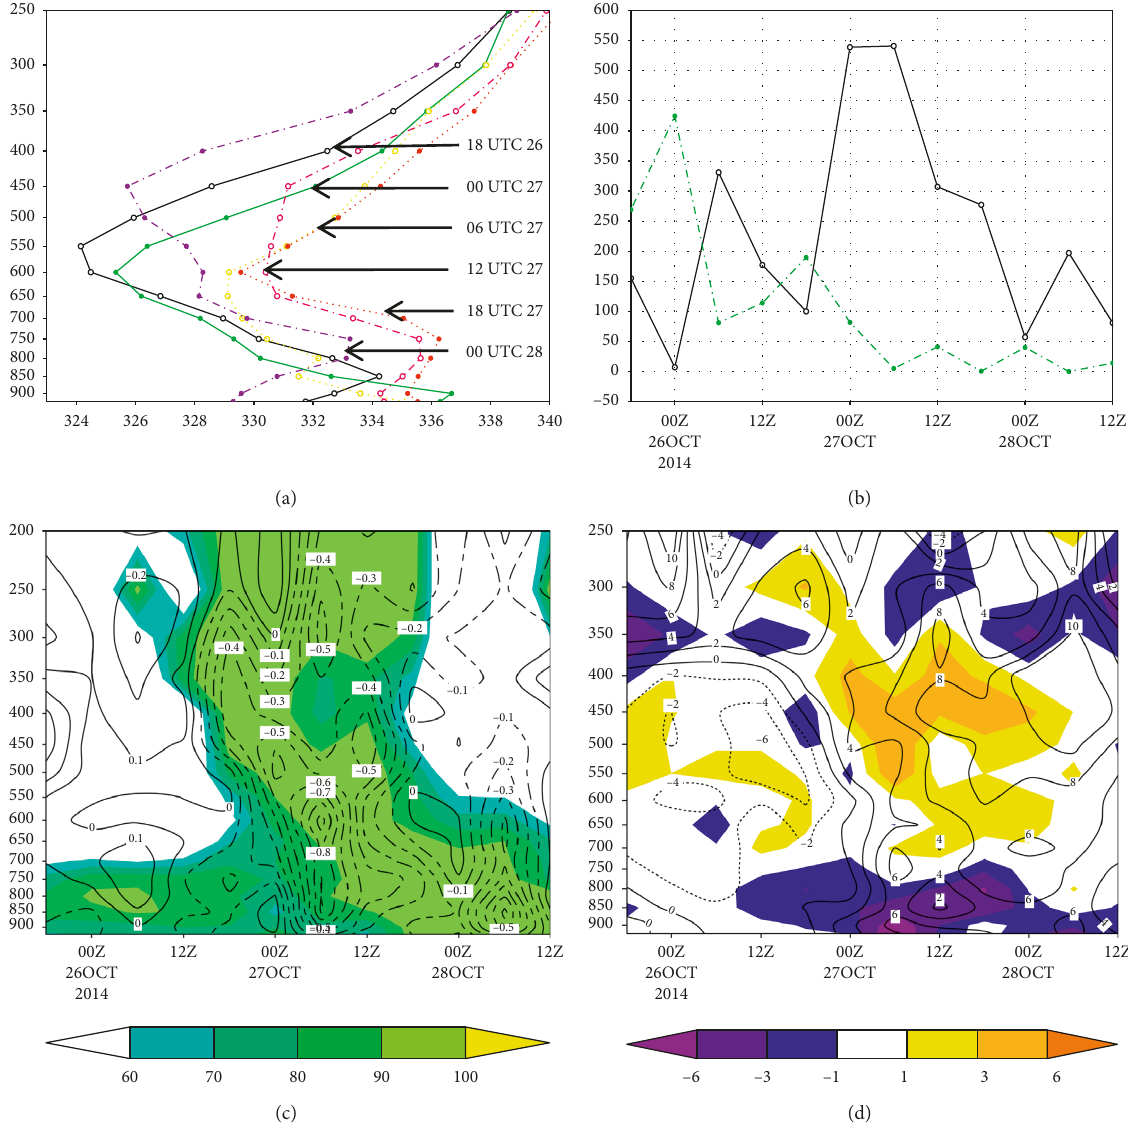
1 ), and CIN (dashed line, J kg · 5 s 1 ) − − −